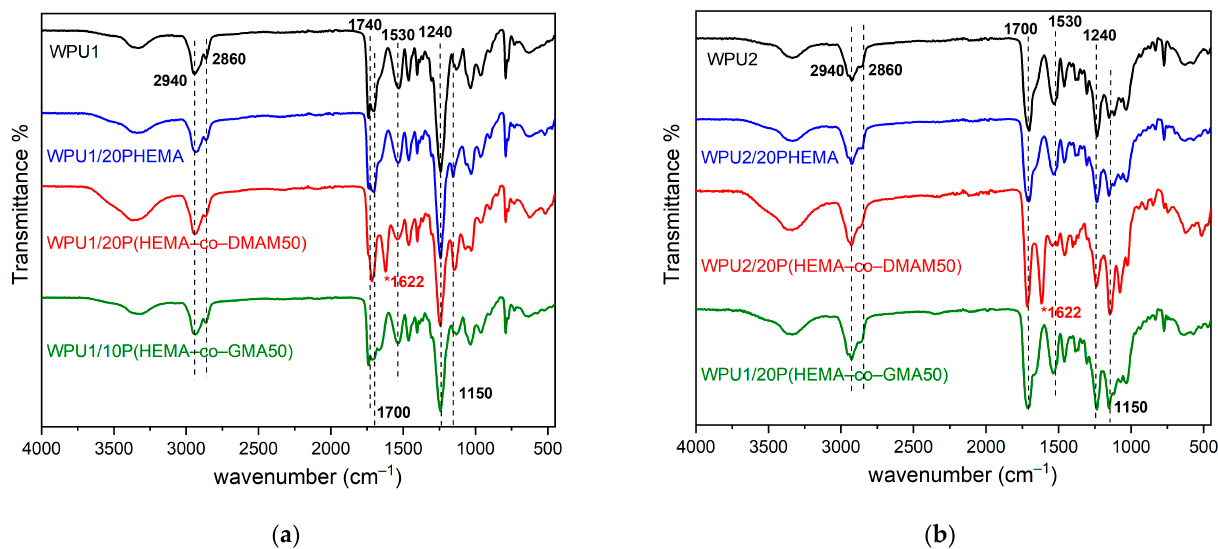
Figure 4. ATR-FTIR spectra of ( a ) WPU1 and ( b ) WPU2 films containing PHEMA, P(HEMA-co- DMAM50) and P(HEMA-co-GMA50) as additives.